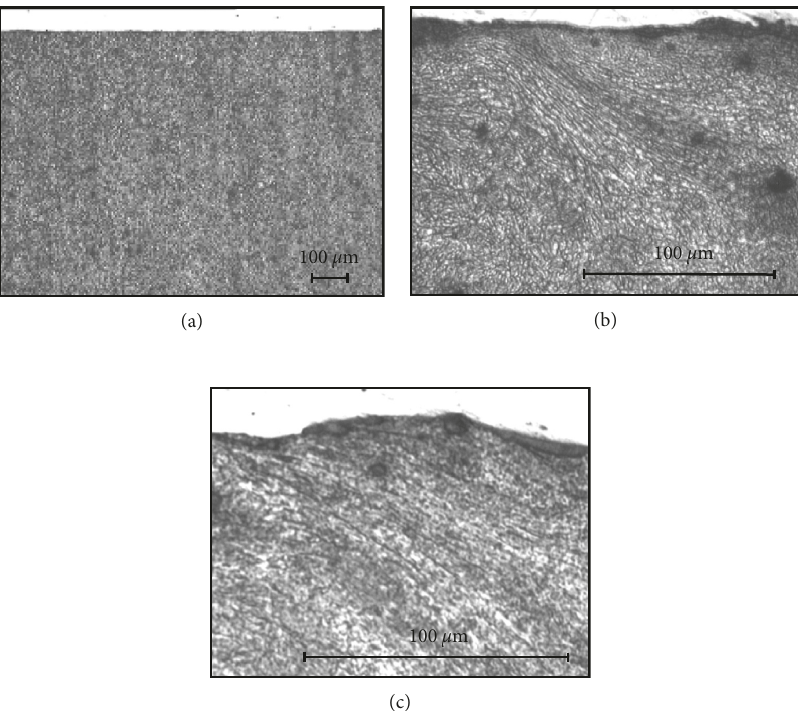
Figure 3: Photos taken on a cross section of an optical microscope: (a) sample ground, larger 50.4x; (b) shot-peened sample (the process parameters: t � 120s, p � 0.45MPa); (c) shot-peened sample (the process parameters: t � 600s, p �